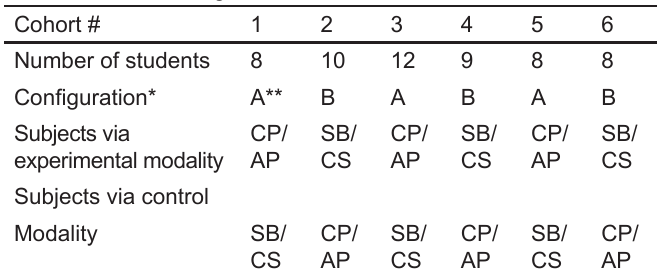
Figure 1. A flowchart of the study design for randomized cross- over study of high- versus low-fidelity